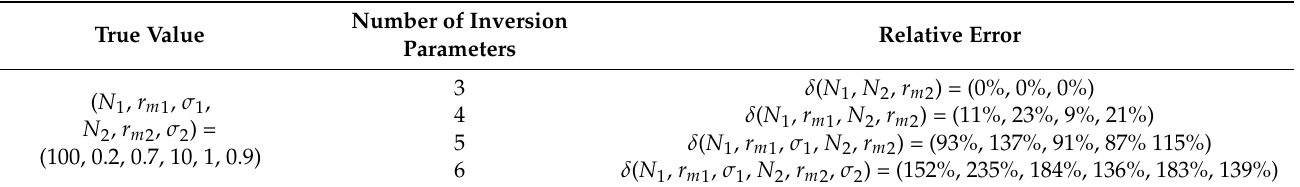
Table 6. The relative errors under different numbers of inversion parameters.